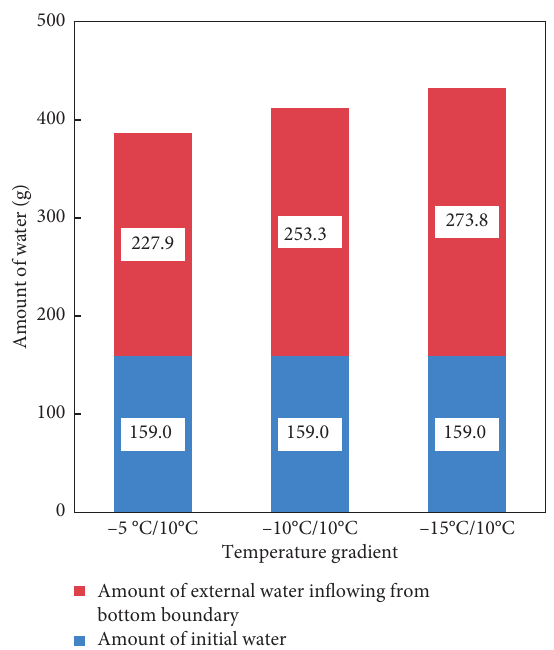
Figure 9: Amount of water in the samples of different temperature